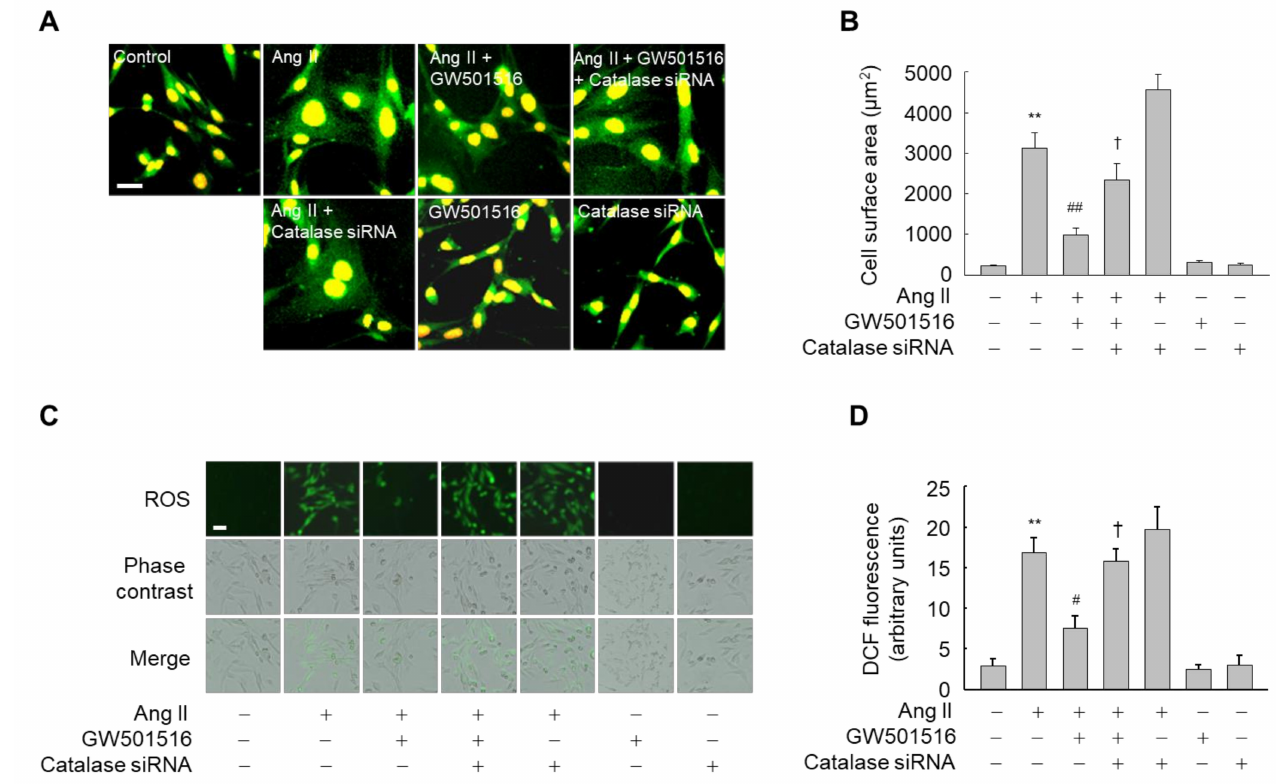
Figure 6. Knockdown of catalase by siRNA abrogates the effects of GW501516 on hypertrophy and ROS production triggered by Ang II in H9c2 cardiomyocytes. Cells transfected with catalase siRNA (200 nM) or control siRNA (200 nM) for 24 h were pretreated with 100 nM GW501516 or vehicle (DMSO) for 12 h, and then stimulated with 100 nM Ang II. Following incubation for 24 h (hypertrophy detection) or 2 h (ROS detection), immunofluorescence assays were performed using α -actinin antibody ( A ), and cell surface area was quantified using an image analyzer and then plotted ( B ). Intracellular ROS accumulation was analyzed by fluorescence microscopy using 10 µ M CM-H2DCF-DA ( C ), and the fluorescence intensity was quantified ( D ). Representative images from four independent experiments are shown. Bars indicate 100 µ m. Results are expressed as mean ± standard error (SE) ( n = 4; ** p < 0.01 compared with the untreated group; ## p < 0.01, # p < 0.05 compared with the Ang II-treated group; † p < 0.05 compared with the Ang II plus GW501516-treated